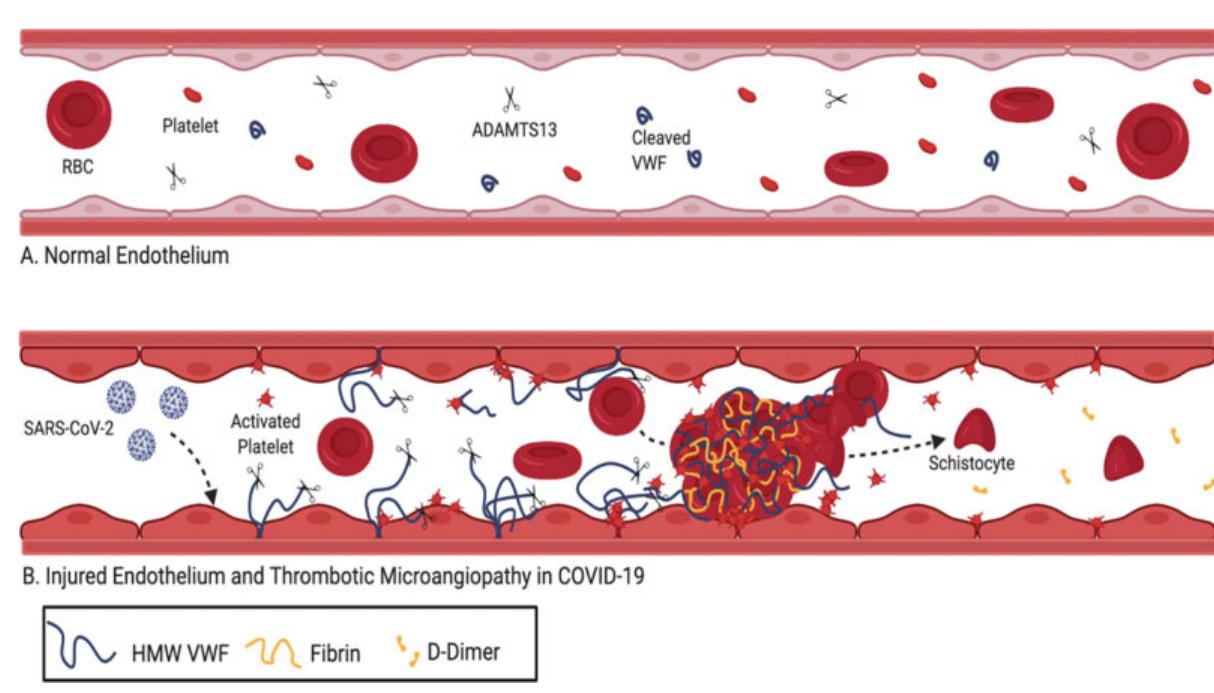
Fig. 4 Unique COVID-19 microangiopathy. ( A ) Normal endothelium. ( B ) SARS-CoV-2 enters the endothelial cells of capillaries via the ACE2R. Injured endothelial cells release HMW multimers of VWF which unfold in shear forces of the microvasculature. HMW multimers recruit platelets to the wounded endothelium. Unfolded HMW multimers consume circulating ADAMTS13 activity, allowing for increased platelet binding to uncleaved HMW multimers downstream. In turn, activated platelets aggregate activating coagulation and forming microvascular thrombi. In high shear stress, schistocytes are formed as a result of RBC shearing while forced through small vessels with thrombi. High D-dimers result from plasmin degradation of microthrombi. ACE2R, ACE2 receptor; ADAMTS13, a disintegrin and metalloproteinase with a thrombospondin type 1 motif, member 13; COVID-19, coronavirus disease 2019; SARS-CoV-2, severe acute respiratory syndrome coronavirus 2. HMW, high molecular weight; VWF, von Willebrand